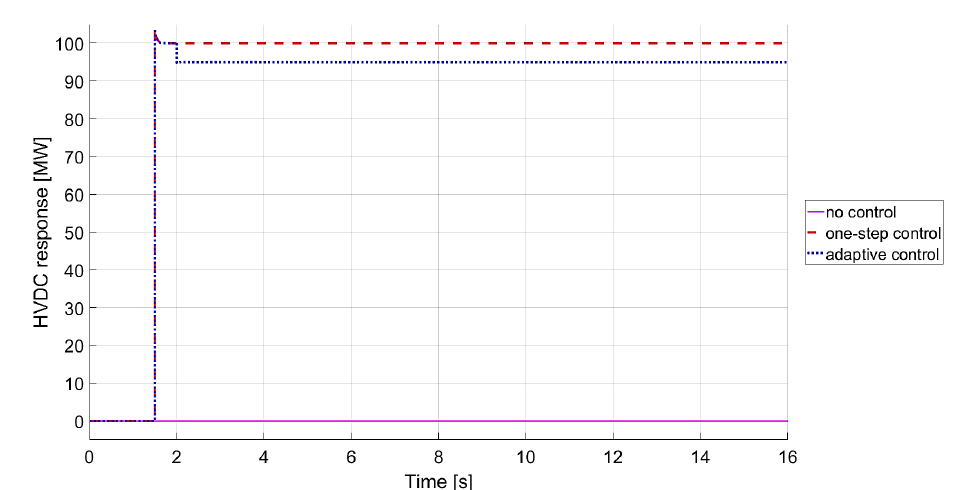
Figure 16. HVDC active power in Configuration I in case of small